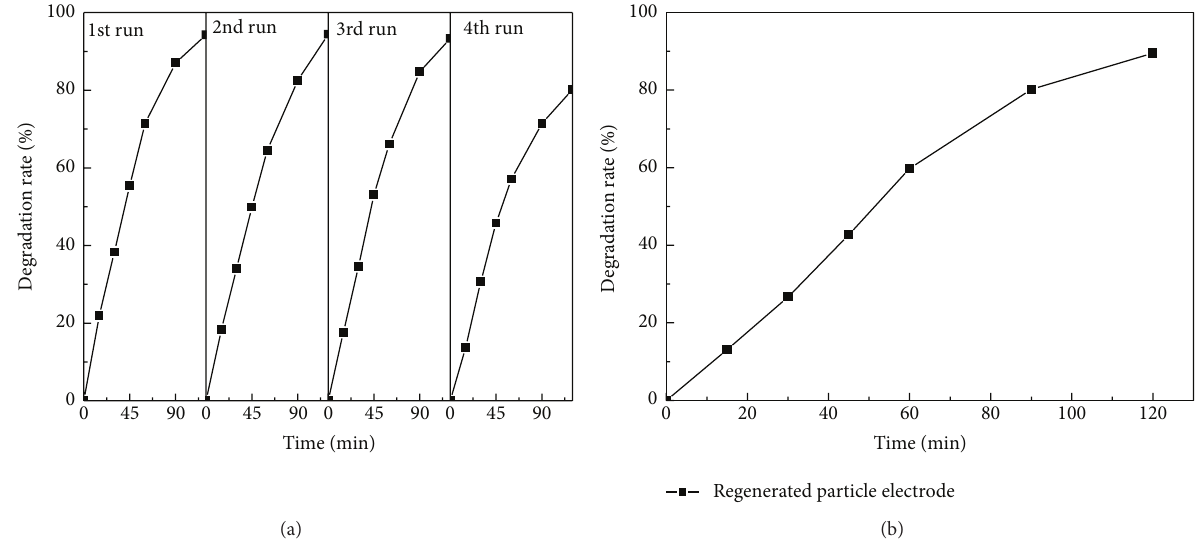
Figure 10: (a) The degradation rate of phenol in four recycling runs; (b) the degradation rate of phenol of regenerated BQP.